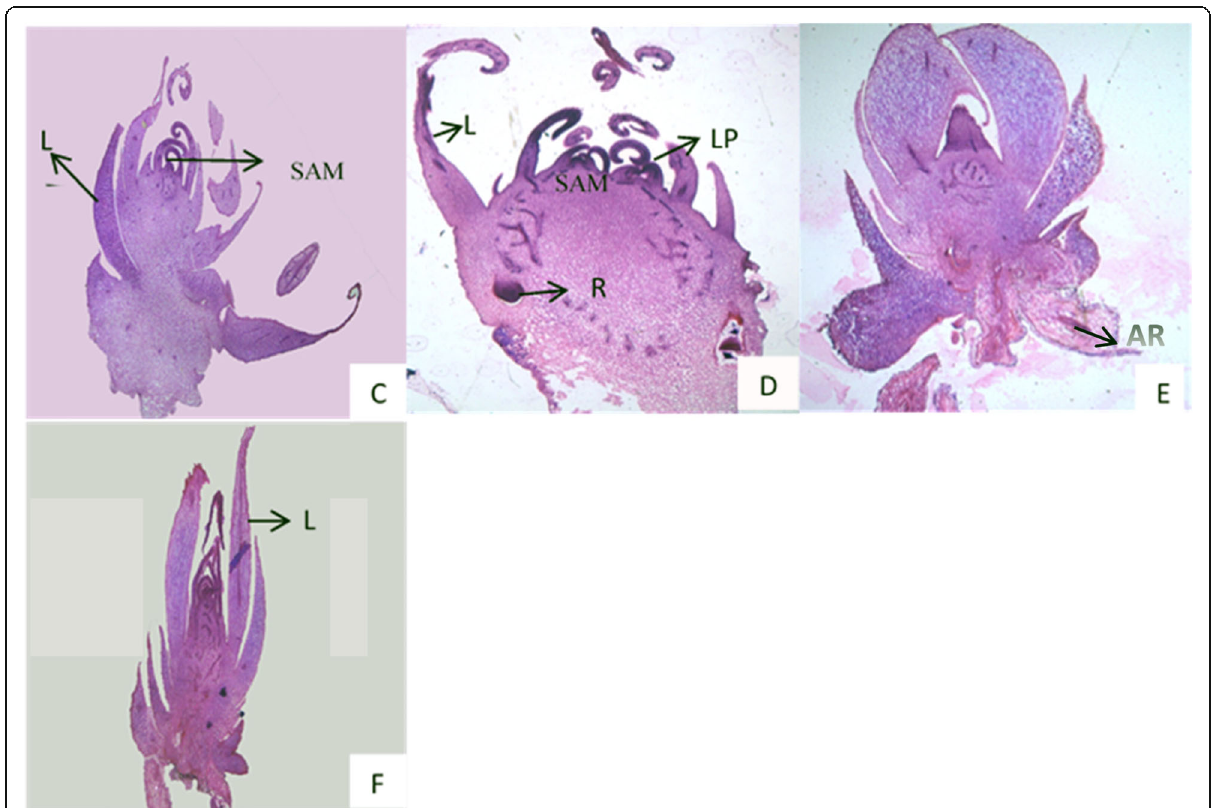
Fig. 3 c Longitudinal section on the plantlet produced on MS medium free of hormones. d, e Longitudinal section on the plantlet grown on MS supplemented with TDZ (0.5 mg/l) + 2,4-D (10 mg/l). f Longitudinal section on the plantlet grown on MS supplemented with TDZ (0.5 mg/l) + 2,4- D (5 mg/l). R, root regeneration; AR, adventitious roots; LP, leaf primordium; L, leaf